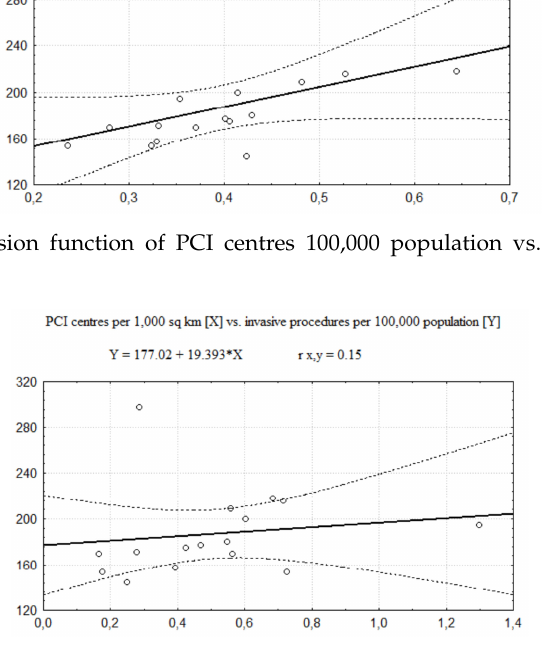
Figure 2. The regression function of PCI per centres per 1000 km 2 vs. number of procedures per invasive procedures per 100,000 population. Table 5. Values of Person correlation coe ffi cient (r X,Y ) for the relationship between the number of PCI centres and number of invasive procedures in the treatment of